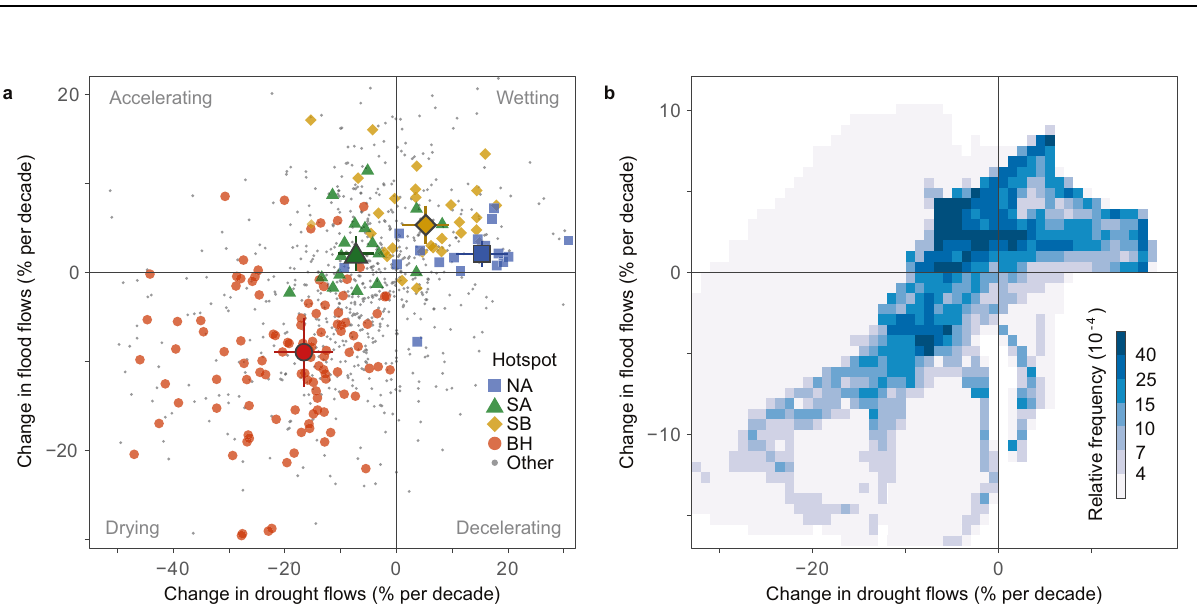
Fig. 3 | Classi fi cation of stream fl ow trends into accelerating, decelerating, wetting, and drying quadrants. a Symbols without borders indicate fl ood and drought fl ow trends of n = 886 stations. Hotspots (Northern Amazonia – NA, Southern Amazonia – SA, Southern Brazil – SB, and Brazilian Highlands – BH) are